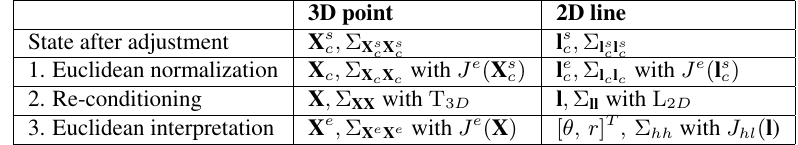
Table 1. Euclidean interpretation of uncertain 3D points and 2D lines